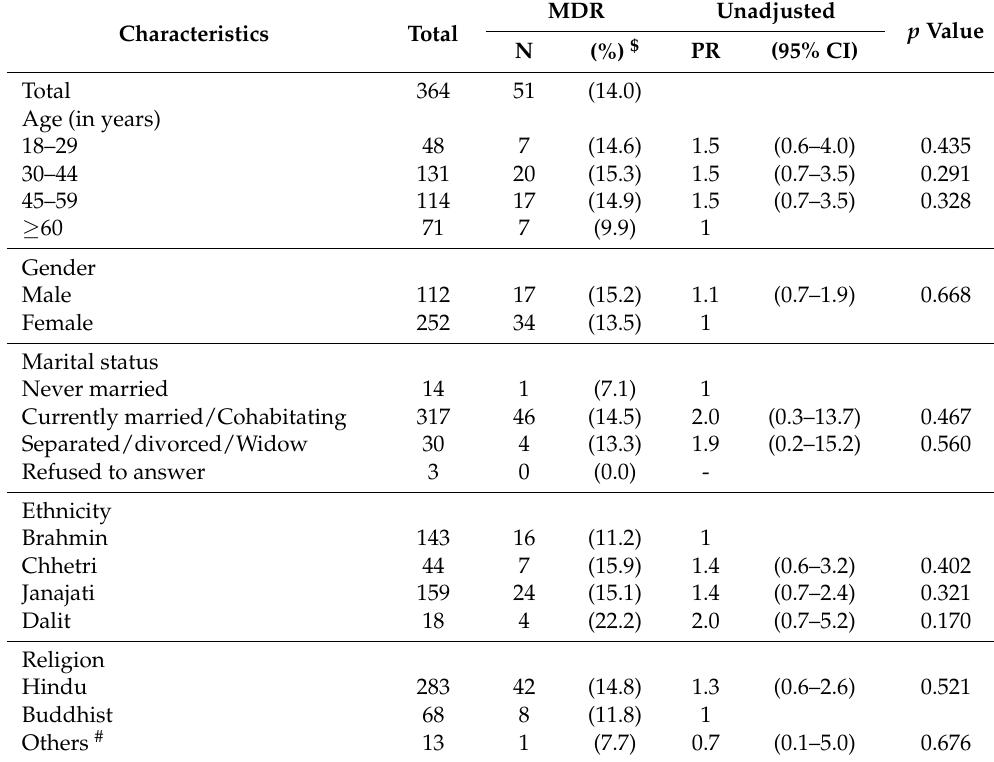
Table 3. Sociodemographic and environmental factors associated with multidrug resistance in E. Coli isolated from the fecal samples of adults in Dhulikhel municipality in Nepal from September to December 2021 (N =